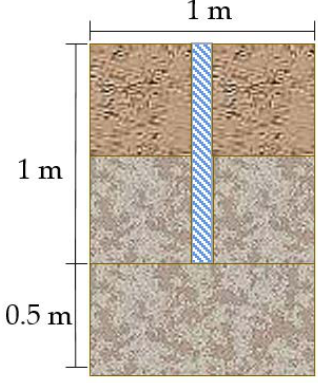
Figure 1. Pile–soil